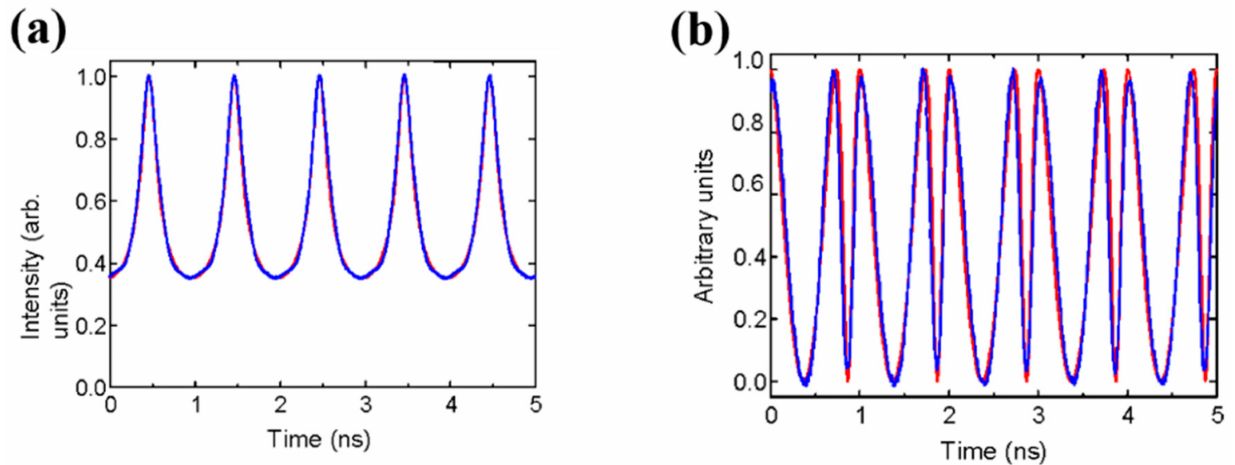
Figure 9. Simulation and experimental results for the PS-FBG-based differentiator. ( a ) Intensity profiles of ( a ) input pulses and ( b ) output pulses. Adapted with permission from ref. [79]. © The Optical